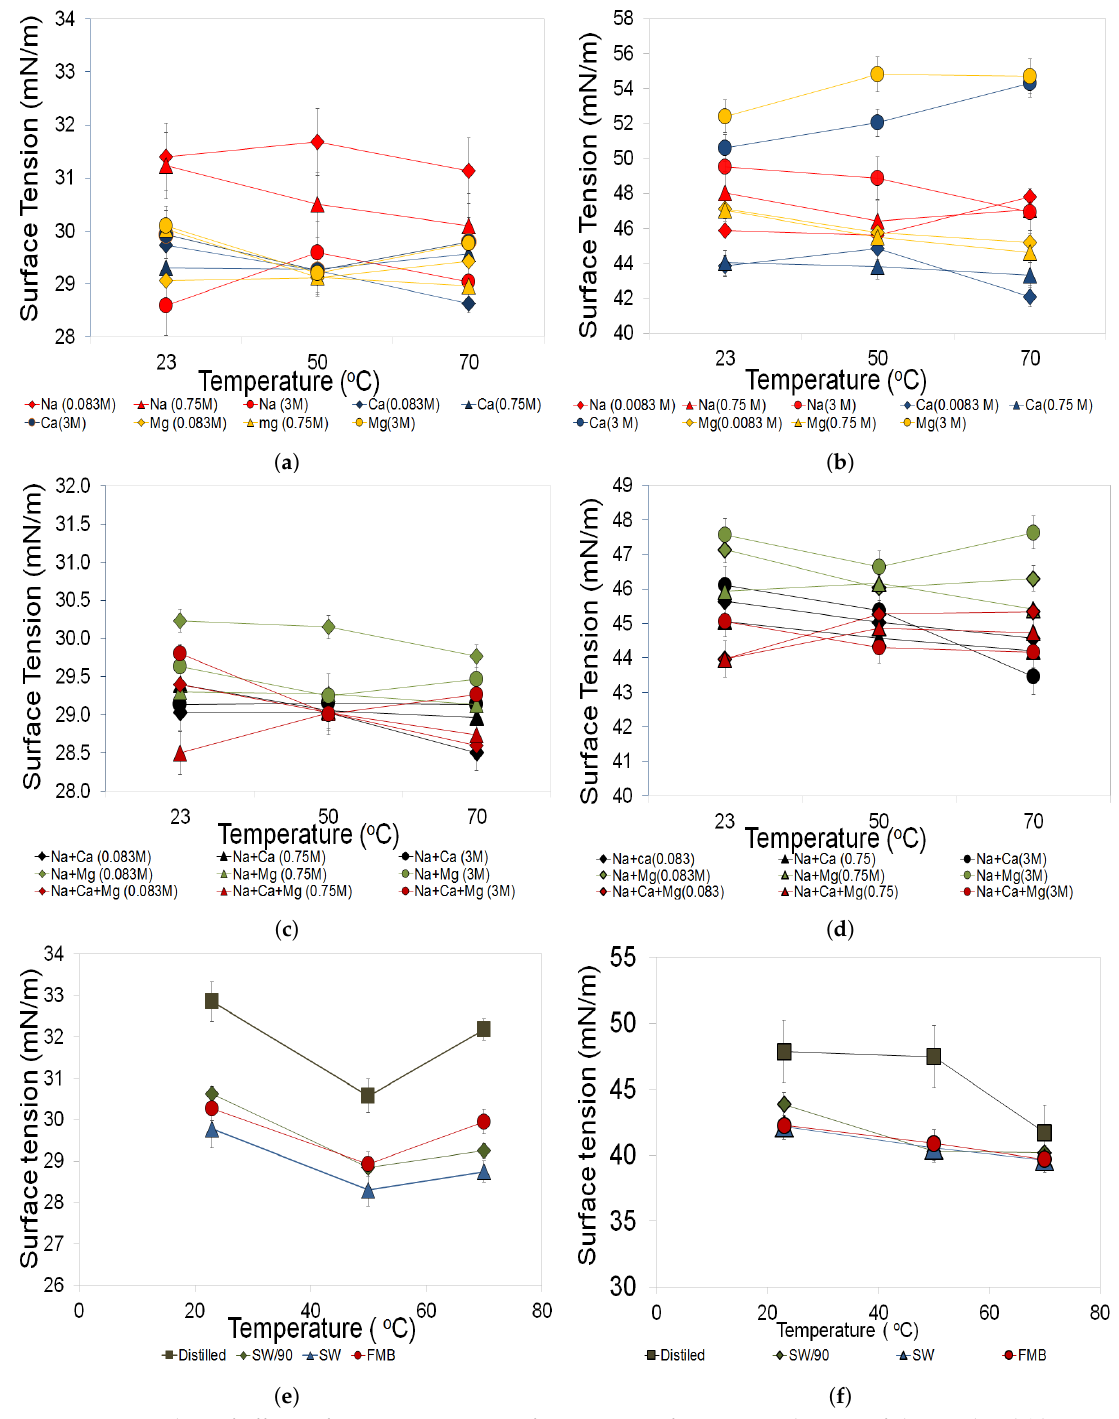
Figure 6. Plots of effects of temperature on surface activity of aqueous solutions of rhamnolipid (the three plots on left— a , c , e ) and Greenzyme (three plots on right— b , d , f ) with different brine compositions and